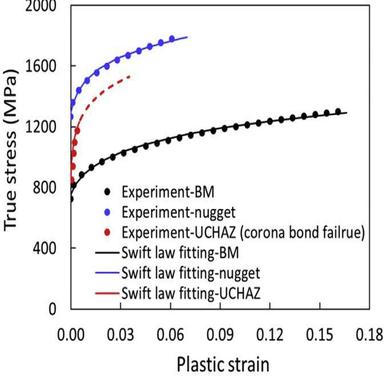
Experimental and swift law fitted flow curves of BM, nugget, and UCHAZ.